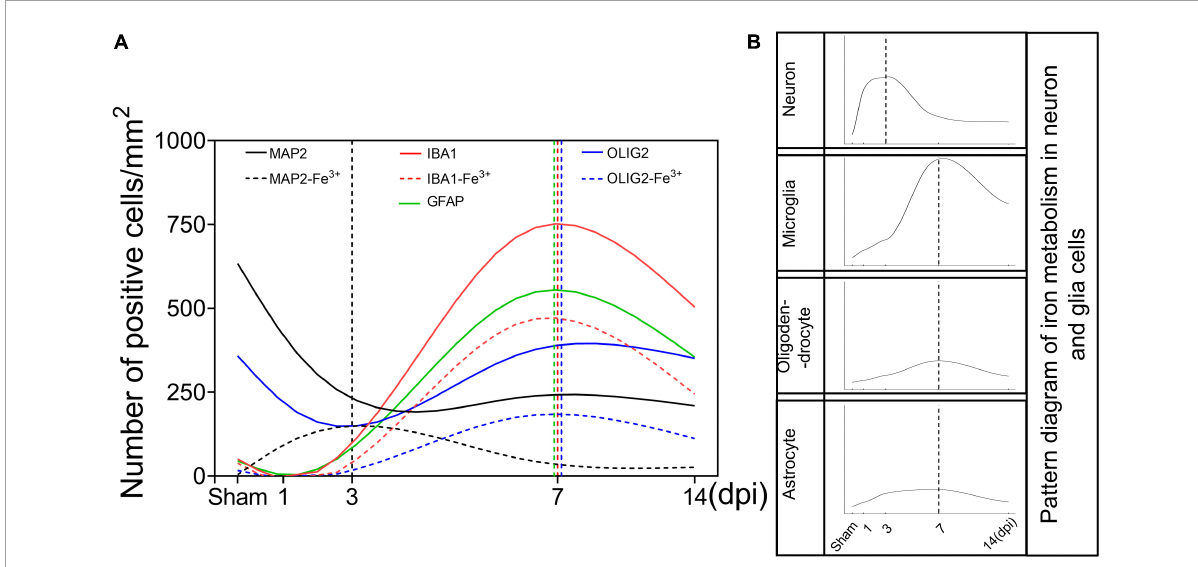
FIGURE6 Schematic curves of iron deposition and iron metabolism in neurons and glia cells after TBI. (A) Temporal changes of the number of neurons and glia cells and the corresponding number of iron positive cells [black line, MAP2 (+); black dotted line, MAP2 (+)-Fe 3 + (+); red line, IBA1 (+); red dotted line, IBA1 (+)-Fe 3 + (+); green line, GFAP (+); blue line, OLIG2 (+); blue dotted line, OLIG2 (+)-Fe 3 + (+)]. (B) Temporal change in the pattern diagram of cellular iron metabolism based on the expression of iron metabolism-related proteins in neurons and glial cells.